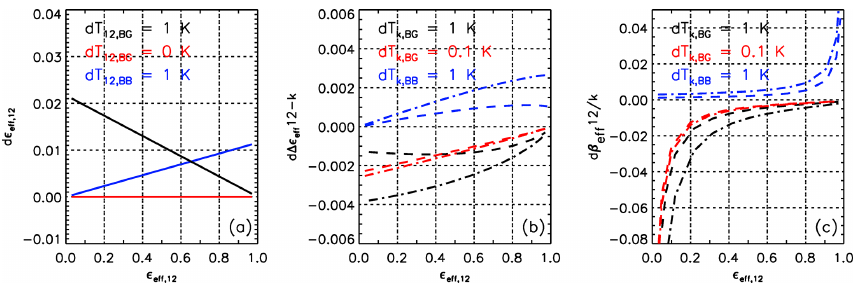
= 0K (red, no error), and d T = + 1K (blue); 12 , BB BG